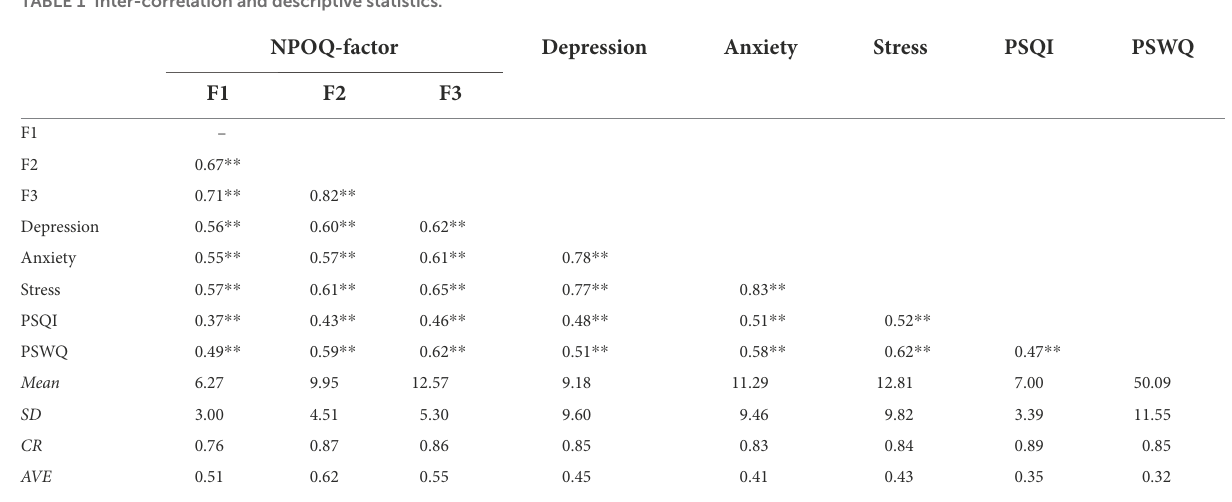
TABLE 1 Inter-correlation and descriptive